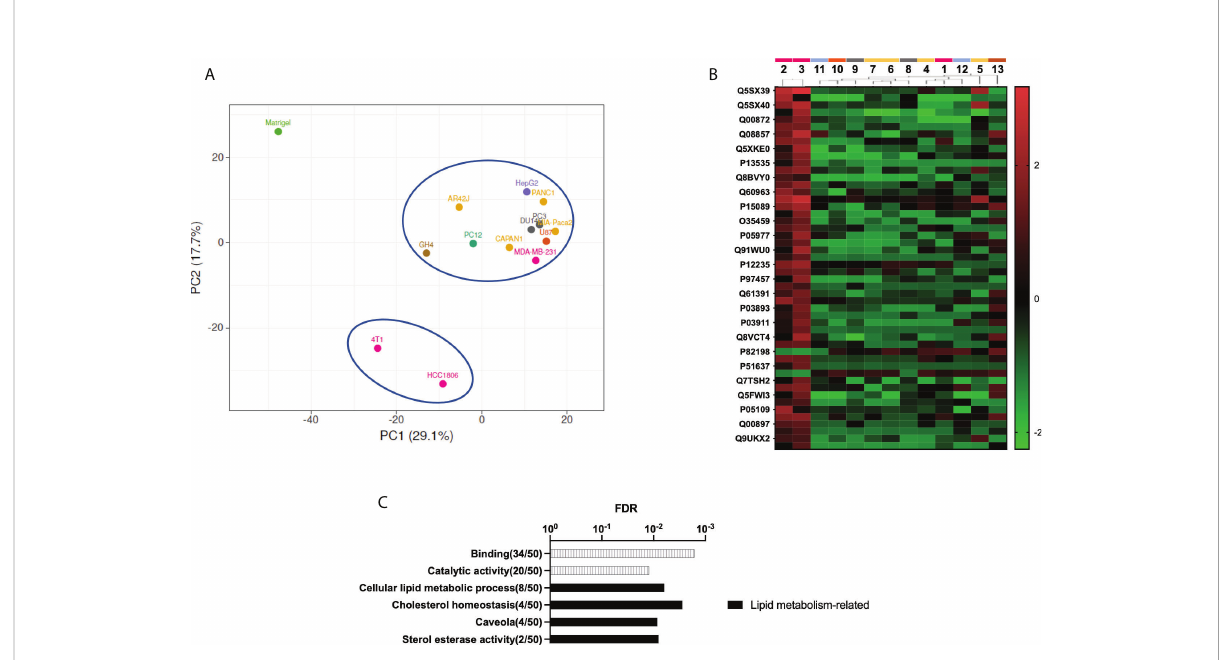
FIGURE 4 Proteomic study shows distinctive ECM on decellularized TNBC xenograft samples. (A) Principal component analysis (PCA). Matrigel control samples are plotted separately from all tumor xenograft samples. Tumor xenograft samples come out splinted into two groups, with the two TNBC xenograft-derived samples separated from the rest of the samples. (B) Heat map representation of the 50 more discriminant proteins obtained by partial least squares discriminant analysis (PLS-DA). (C) GO analysis of the 50 more discriminant proteins. Note: cell line number codes are provided in Table 1. The same tumor color codes are used in all panels of the fi